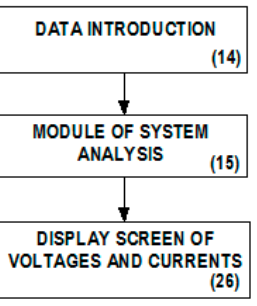
Figure 7. Voltage and current programming module.